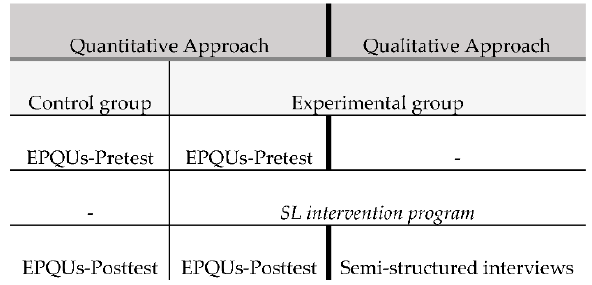
Figure 1. Mixed methods with predominantly quasi-experimental quantitative design used.